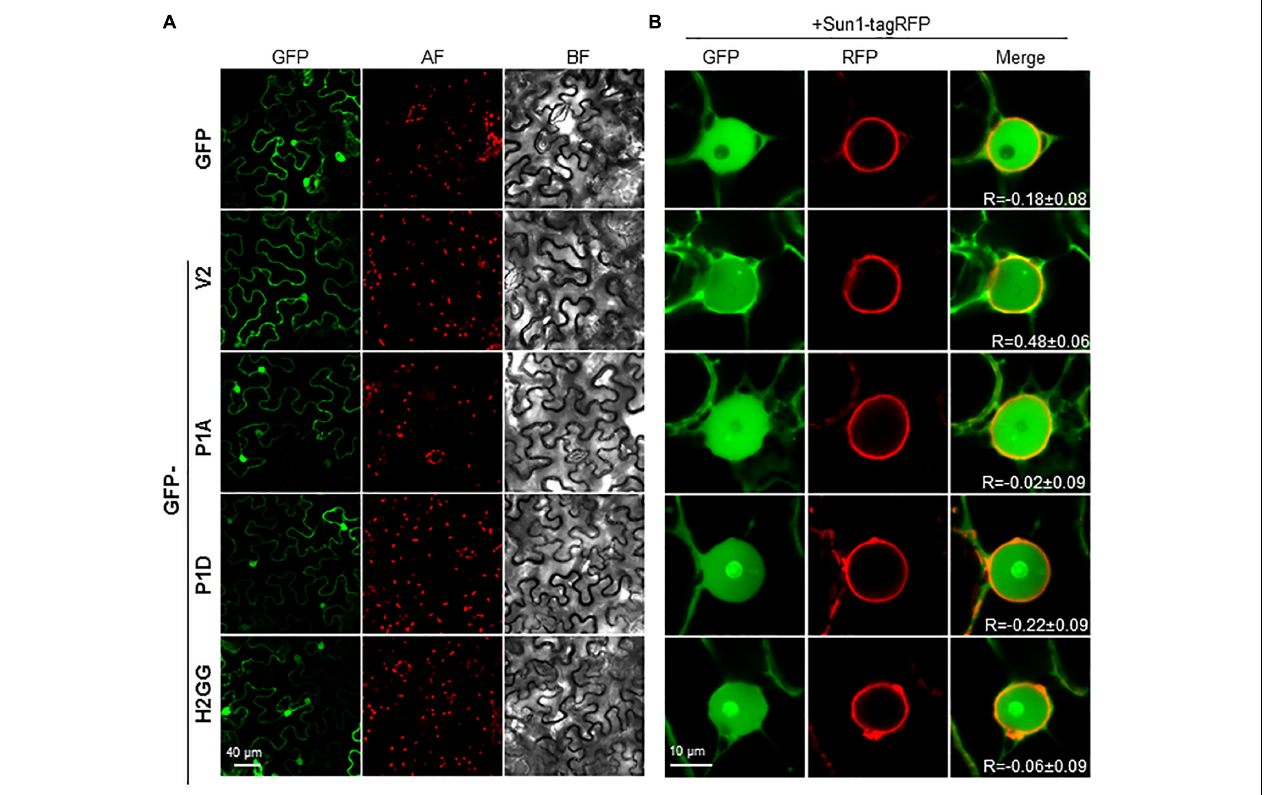
FIGURE 5 | Subcellular localization of V2 mutants fused to GFP protein in epidermal cells of N. benthamiana. (A) Leaves were agroinfiltrated with a construct expressing the 35S:GFP (GFP), 35S:GFP-V2 fusion protein or the 35S:GFP-V2 mutants. Samples were observed under the confocal microscope at 2 dpi. GFP fluorescence (GFP), autofluorescence (AF) and the bright field channel (BF) are shown. (B) Co-localization of 35S:GFP-V2 (wt and mutants) and the nuclear envelope marker 35S:AtSUN1–tagRFP. Leaves were agroinfiltrated with a construct expressing the GFP-V2 fusion protein or the GFP-V2 mutants and the nuclear envelope marker AtSUN1–tagRFP and observed under the confocal microscope at 3 dpi. GFP fluorescence (GFP), RFP fluorescence (RFP), and merge are shown. R stands for the Pearson’s correlation coefficient for GFP-fusions and SUN1-tagRFP (mean values ± standard error (SE) from 6 to 9